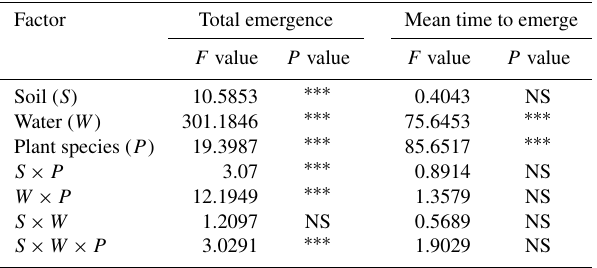
Table 4. Effects of soil or growth media type, water treatments and plant species, and interactive effects of these factors on total emergence and mean time to emerge. Statistical significance